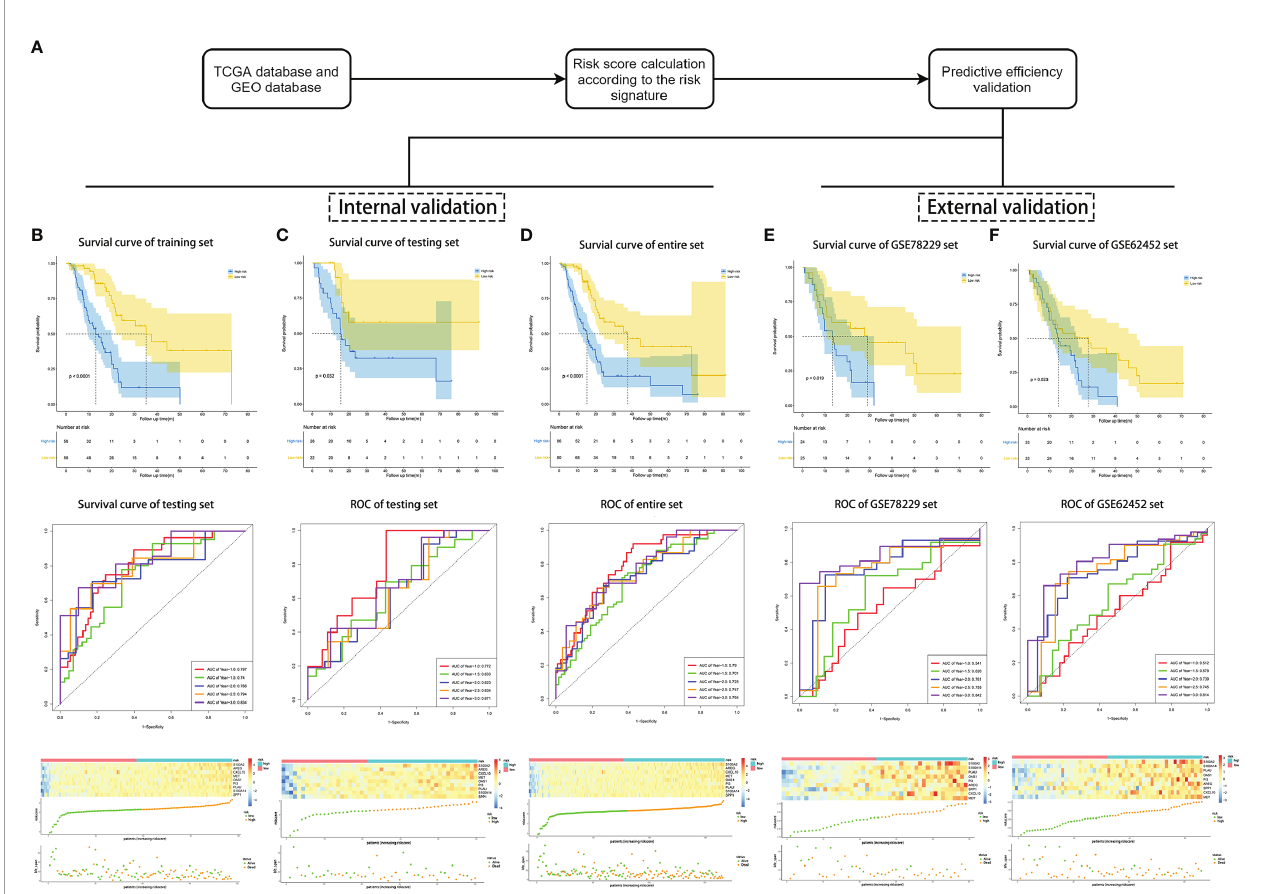
FIGURE 2 | Validation of the risk signature for survival prediction in training set, testing set, entire TCGA set, GSE78229 set, and GSE62452 set. (A) The process of the risk signature validation. (B – F) Kaplan – Meier analysis of OS of the risk signature, time-dependent ROC analysis of the risk signature, heatmap of the nine hub genes expression, the risk scores distribution and survival status of the patients in training set (B) , testing set (C) , entire TCGA set (D) , GSE78229 set (E) , and GSE62452 set (F)